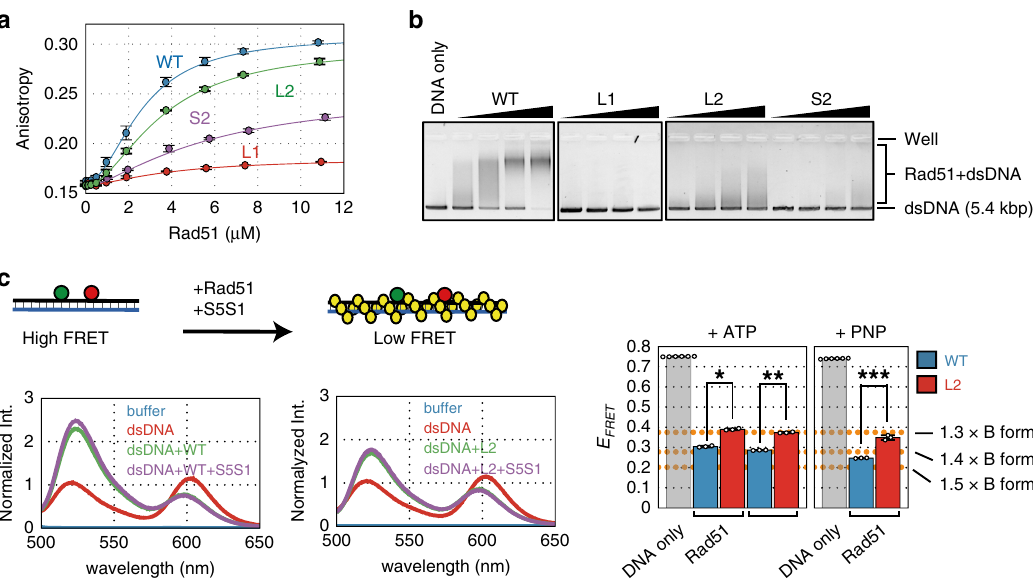
Fig. 6 Rad51-L1 and -S2 are defecting in dsDNA binding, whereas Rad51-L2 binds but does not completely elongate dsDNA. a Formation of Rad51- dsDNA fi laments by wild-type Rad51 (blue), Rad51-L1 (red), -L2 (green), or -S2 (purple) was observed by measuring fl uorescence anisotropy. Rad51 protein was titrated into the reaction mixture containing dsDNA (3 µ M bp). b Gel shift assay. Various concentrations of wild-type and mutant Rad51 proteins (1.25, 2.5, 5.0, and 10 µ M) were mixed with dsDNA (10 µ M nucleotide). After incubation at 37 °C for 15 min, Rad51-dsDNA fi laments were cross- linked with glutaraldehyde. c Elongation of Rad51-dsDNA fi lament. (upper) Schematic diagram depicting observation of the elongation of Rad51-dsDNA fi lament using FRET. Emission spectra of fl uorescein (green) and rhodamine (red), which are separated by 11 nucleotides on the same strand, were collected by excitation at 493 nm. Yellow balls represent Rad51 monomers. (lower) Emission spectra of fl uorescein and rhodamine. Wild-type Rad51 (lower left) or Rad51-L2 (lower center) (8 µ M each) and Swi5-Sfr1 (0.8 µ M) were mixed with the double-labeled dsDNA (3 µ M bp) and the emission spectra of fl uorescein and rhodamine were collected after excitation at 493 nm, as described in the “ Methods ” . (lower right) FRET ef fi ciency ( E FRET ) of each reaction condition containing wild-type Rad51 or Rad51-L2 in the presence of ATP or AMP-PNP was calculated from the emission spectra shown here and in Supplementary Fig. 5. Orange dot-lines in d , e show the distances between two fl uorophores compared with B-form DNA. * p = 1.32 × 10 − 5 , ** p = 4.17 × 10 − 13 and *** p = 1.17 × 10 − 5 by two-tailed Student ′ s t test. Data ( a , c ) are expressed as the mean ± s.d. ( n = 3 independent experiments, except n = 6 independent experiments for DNA only in c ). Source data are provided as a Source data fi